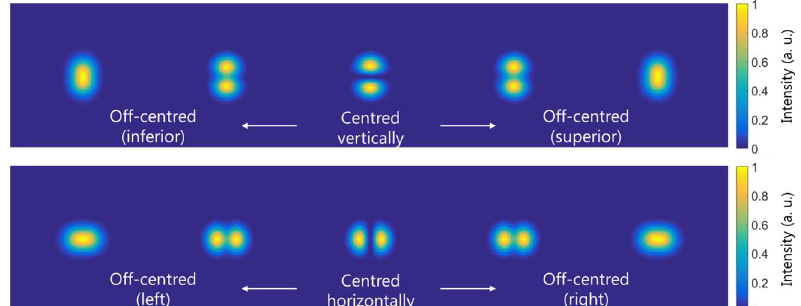
Figure 3. Simulated transversal intensity distributions at the CCD 2 plane, when the CGH is illu- minated with the LP 01 mode and the ( a ) LP 11e and ( b ) LP 11e modes are implemented in the SLM, for different transversal displacements of the CGH. The optical axis point is marked with a red